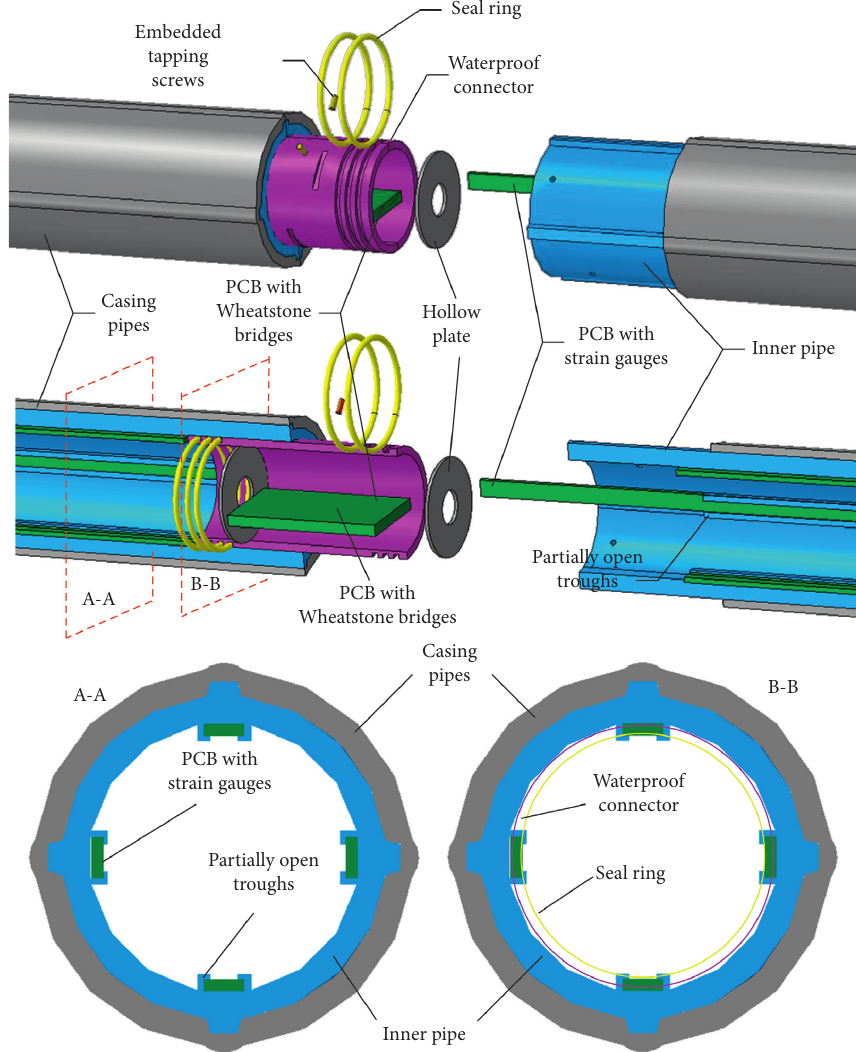
Figure 1: Schematic diagram of the structure of the double layered measuring pipes.